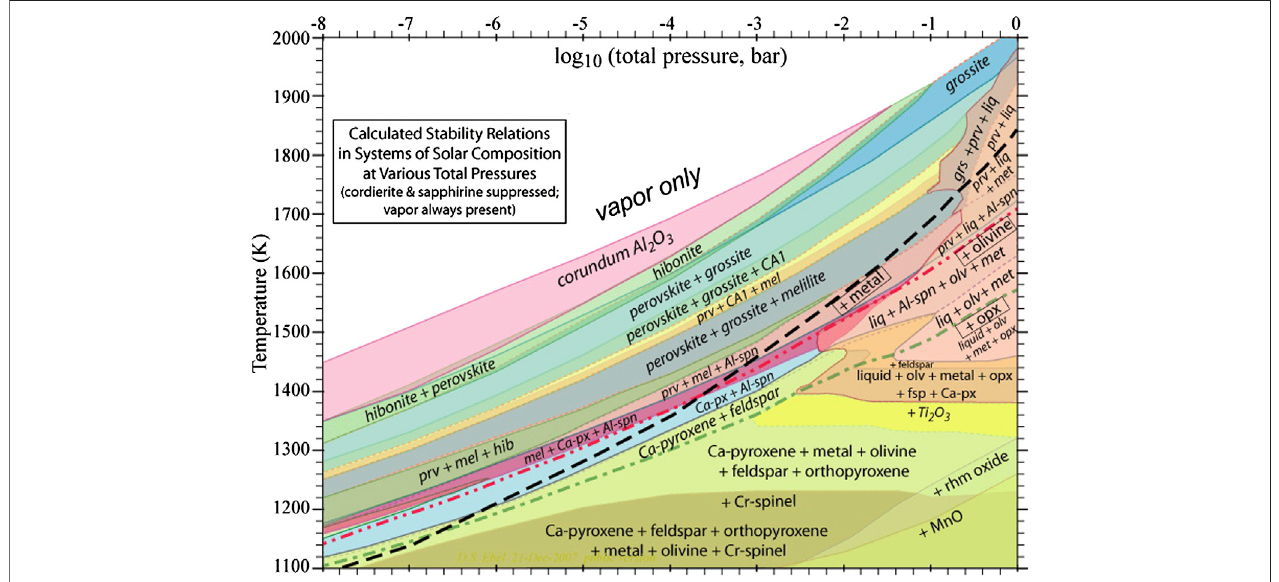
FIGURE 1 | Equilibrium stability regime of compounds in a nebula of solar elemental composition calculated using chemical thermodynamics. As the (inner) solar nebula cooled down from high temperatures, different compounds will condense out sequentially. The major condensates of metal, olivine, and orthopyroxene are indicated by dashed, dashed-dot-dot and dashed-dot lines, respectively. Figure taken from Ebel (2006).